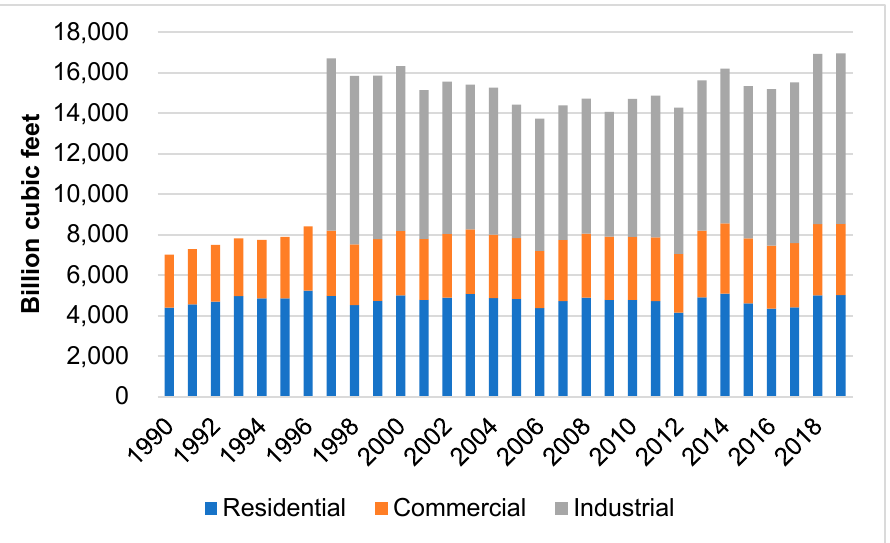
Figure 1. US annual natural gas consumption by end-use customer class in 1991–2019, recognizing that annual industrial consumption data are unavailable for years prior to 1997 (Data source: US Energy Information Agency).